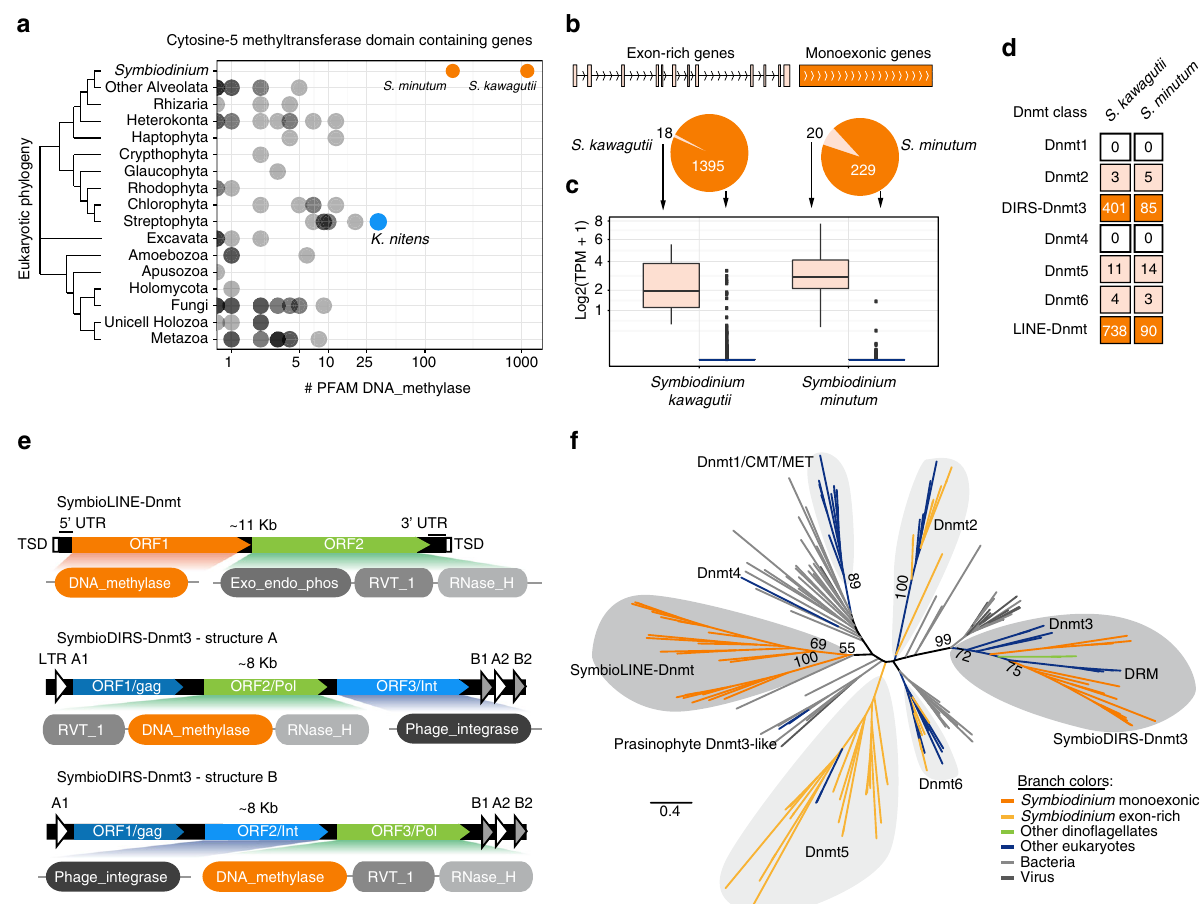
Fig. 1 Symbiodinium genomes encode hundreds of DNMTs. a Number of DNMT genes encoded in eukaryotic lineages based on a data set of 96 genomes (Supplementary Data 1). Each dot corresponds to the number of genes containing a DNMT domain (PF00145, DNA_methylase) in a given genome. b Proportion of distinct DNMT gene architectures in Symbiodinium , pale shade for exon-rich, darker shade for monoexonic. c Transcriptional level of DNMT- encoding genes according to gene architecture in Symbiodinium . Boxplot centre lines are medians, box limits are quartiles 1 (Q1) and 3 (Q3), whiskers are 1.5 × interquartile range (IQR) and points are outliers. d Classi fi cation of DNMTs in Symbiodinium genomes, showing number of copies per family. Colour code re fl ects the type of gene architecture for each family: pale shade = exon-rich, darker shade = monoexonic. e Structure of Symbiodinium retrotransposons that encode for DNMTs and domain architectures of the open reading frames (ORFs). Domains named as in Pfam searches: Exo_endo_phos (PF03372) is an endonuclease domain, RVT_1(PF00078) is a reverse transcriptase, RNase_H (PF00075) is a RNase type H and Phage Integrase (PF00589) is a tyrosine recombinase. SymbioLINE-Dnmt show fl anking tandem site duplications (TSD), conserved 5 ′ and 3 ′ UTR regions and lack Poly-A tails. SymbioDIRS-Dnmt3 show two sets of LTRs (represented by triangles A and B) in an arrangement typical of DIRS retrotransposons: A- coding region-B-A-B. f Maximum likelihood phylogenetic tree of a representative group of eukaryotic, bacterial and Symbiodinium DNMTs. Hundred parametric bootstrap replicates are shown as nodal supports for selected groups. Colour code indicates sequence taxonomic af fi liation of each branch as shown in